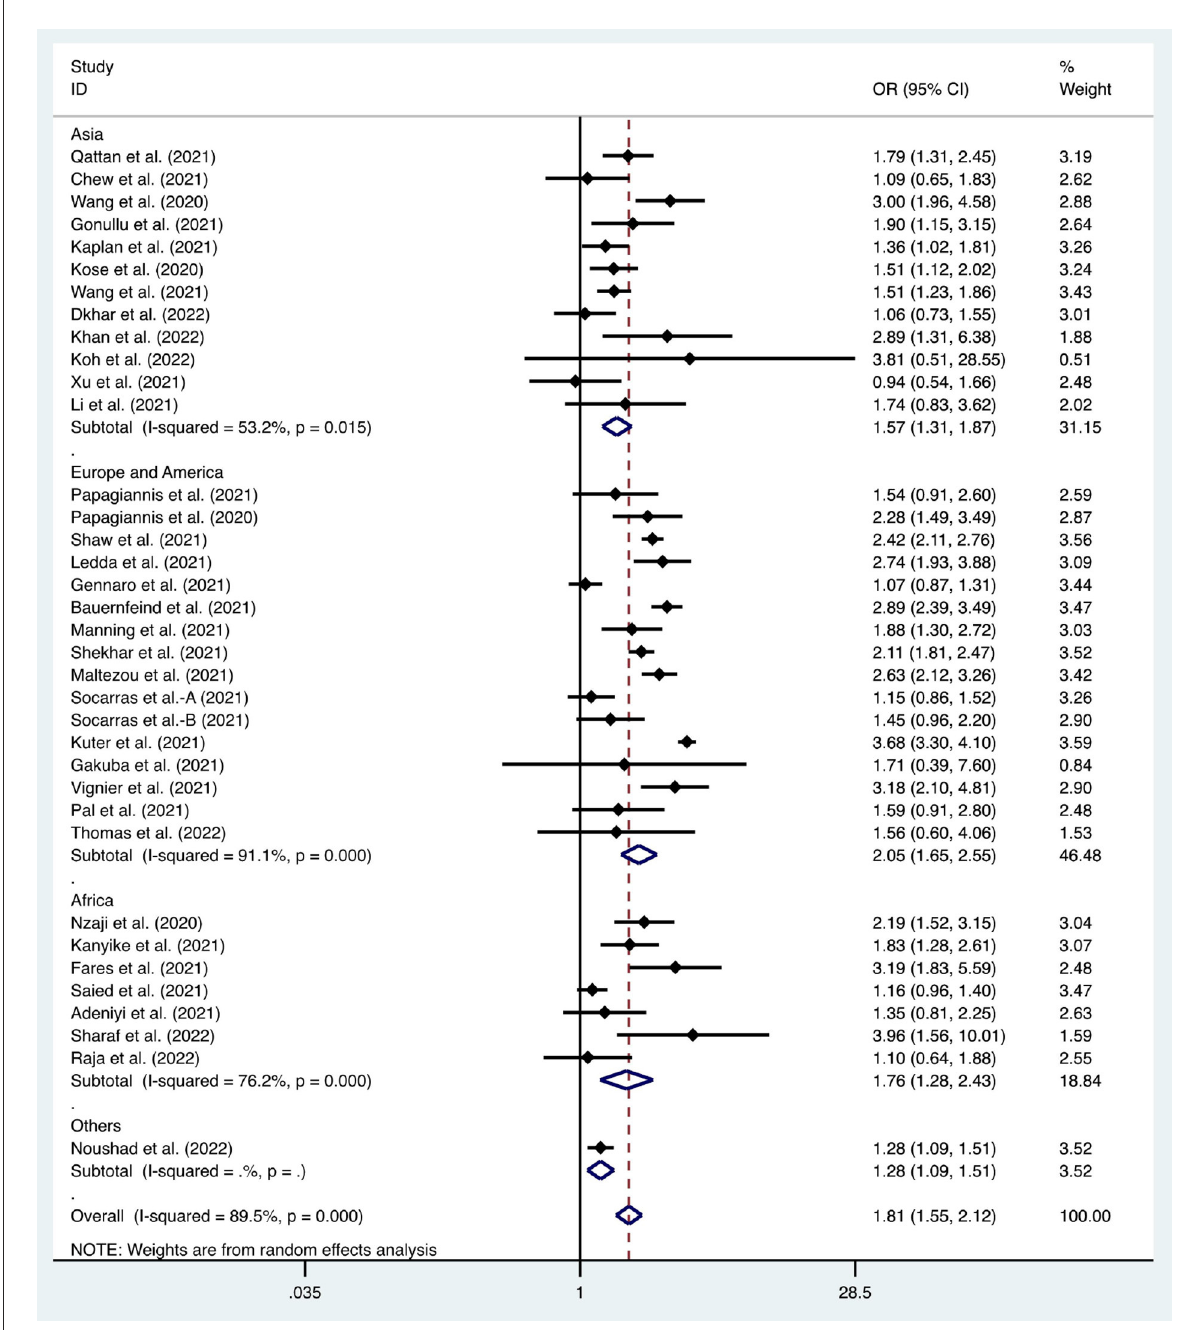
FIGURE7 Forest plot of the effect of gender on the willingness of healthcare workers to receive coronavirus disease 2019 vaccines.